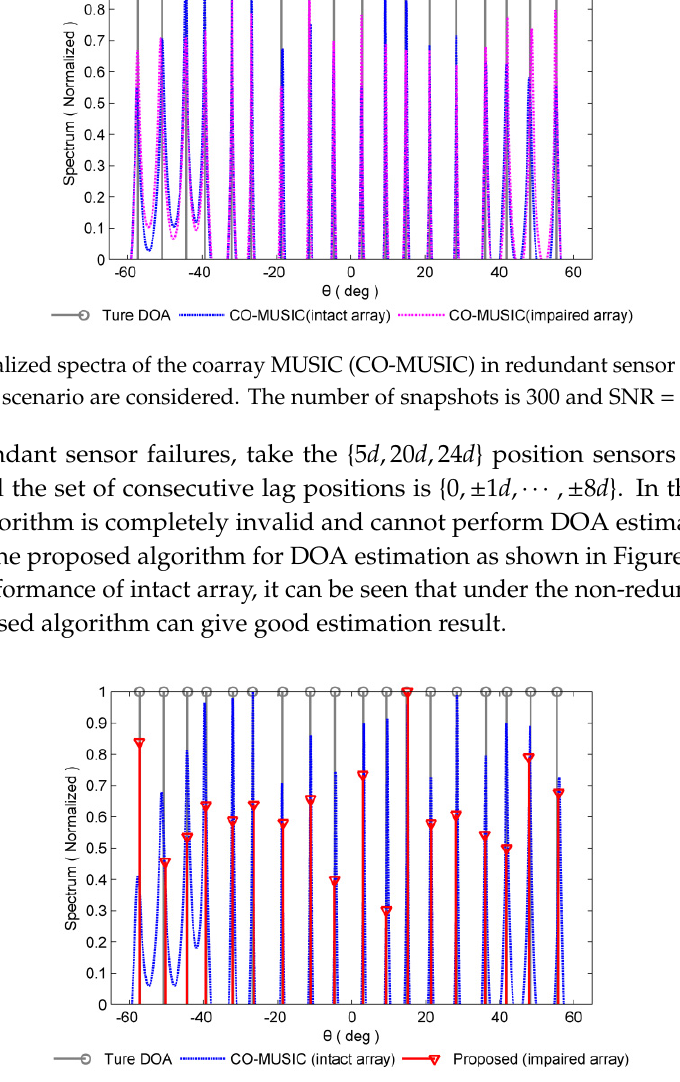
Figure 5. Normalized spectra of the proposed method in non ‐ redundant sensor failures scenario and the CO ‐ MUSIC in intact array scenario are considered. The number of snapshots is 300 and SNR = 0 dB.